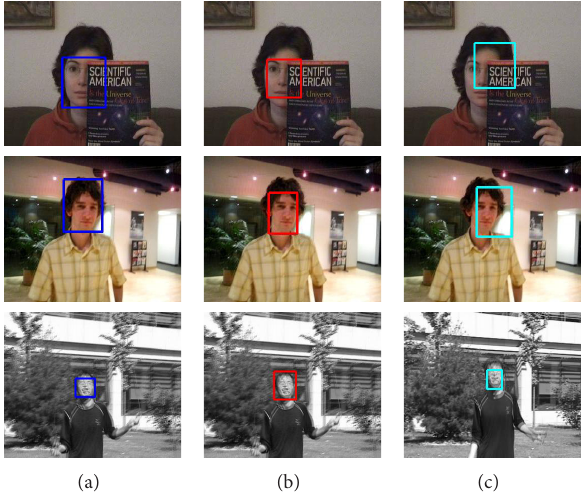
Figure 2: (a) Ground truth. (b) Tracking results with weighted P-N learning. (c) Tracking results based on P-N